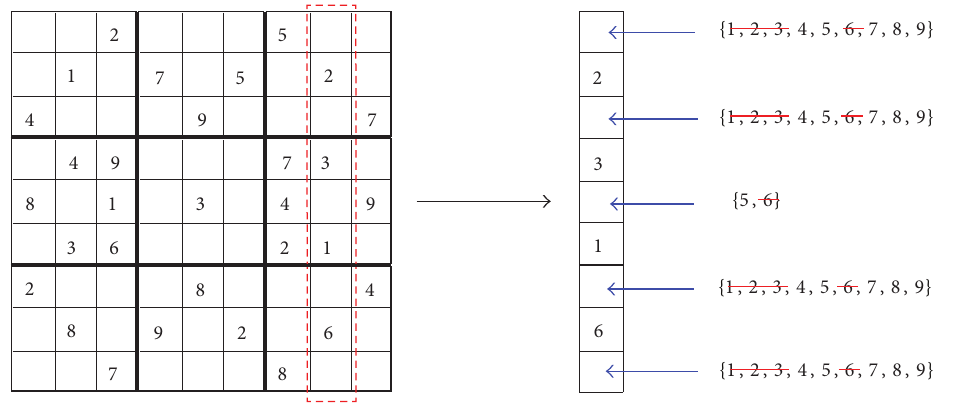
Figure 4: Enforcing AC3 to a column